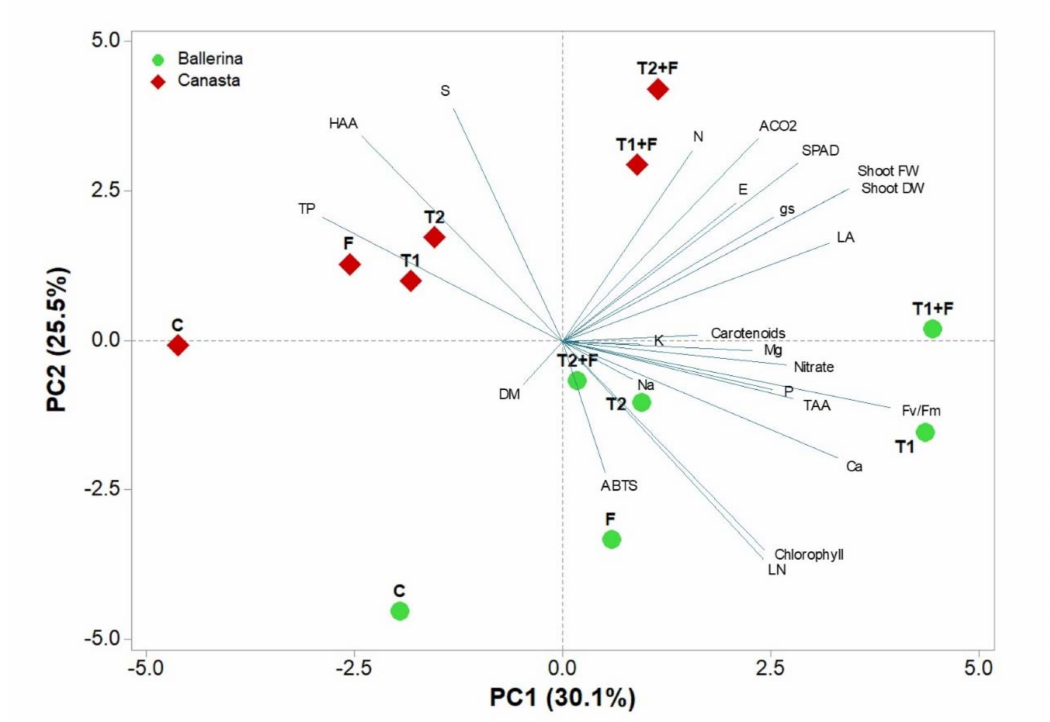
Figure 1. Principal component loading plot and scores of principal component analysis (PCA) on biometric (shoot fresh weight (FW), shoot dry weight (DW), dry matter % (DM) leaf number (LF) and Leaf Area (LA)), mineral (Nitrate, P, K, Ca, Mg, S and Na), qualitative (Total chlorophylls, Hydrophilic antioxidant activity (HAA), ABTS antioxidant activity, carotenoids, total phenols (TP) and total ascorbic acid (TAA)) and physiological aspects (SPAD index, fluorescence (F v :F m ratio), assimilated CO 2 (A CO2) , stomatal conductance (g s ) and transpiration rate (E)) of ‘Canasta’ and ‘Ballerina’ lettuce as influenced by the biostimulant application mode and dose (F: foliar treatment (3 mL L − 1 ), T1: nutrient solution treatment 0.15 mL L − 1 , T2: nutrient solution treatment 0.3 mL L − 1